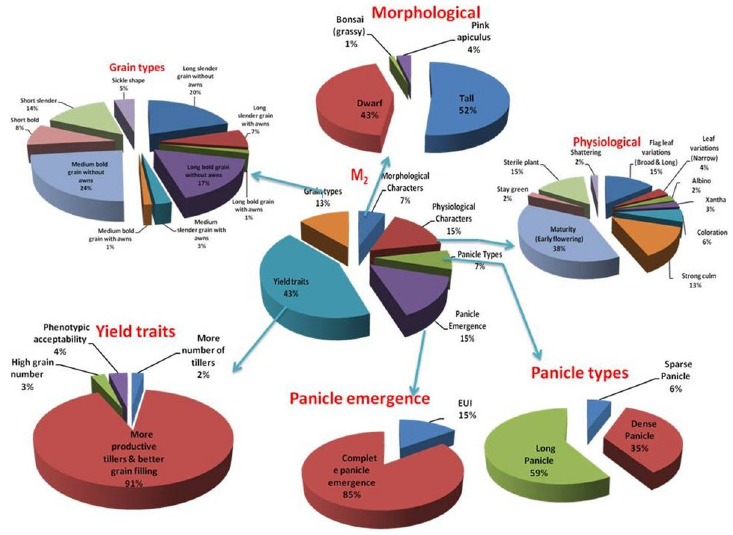
Fig 1. Distribution of mutants for various agro-morphological traits in M 2 generation.